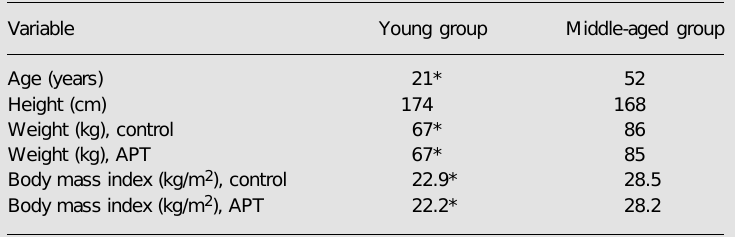
Table 1. Comparison of the anthropometric data for the subjects before (control) and after three months of aerobic physical training